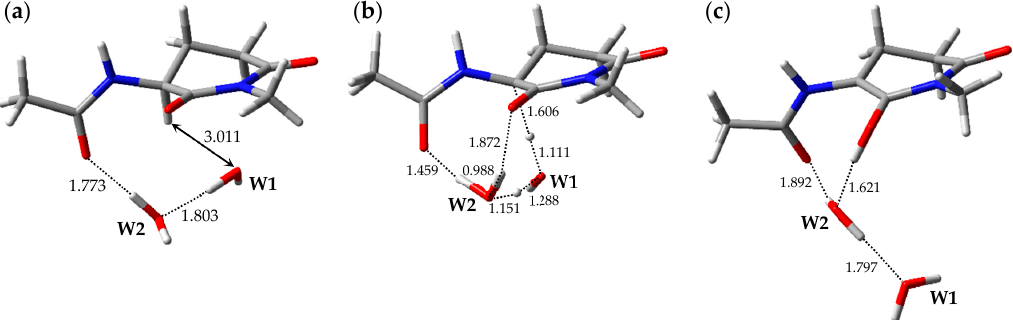
Figure 2. Optimized geometries of the enolization system in Pathway 1: ( a ) 1-RC ( φ = − 101°, ψ = − 159°, χ 1 = − 179°, χ 2 = − 53°); ( b ) 1-TS ( φ = − 88°, ψ = − 152°, χ 1 = 177°, χ 2 = − 48°); and ( c ) 1-PC ( φ = − 100°, ψ = − 171°, χ 1 = − 158°, χ 2 = − 46°). The selected interatomic distances are shown in Å.